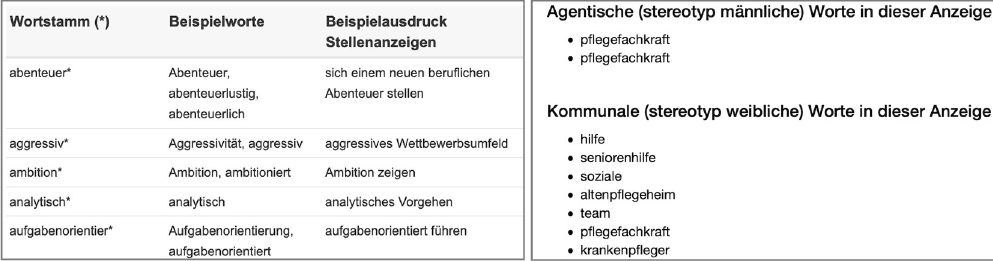
Fig 2. Word stems and examples of matching words in Fu¨hrMINT. Left: Sample of agentic word stems with word and context examples in job ad texts. Right: Example of extracted agentic and communal words. The word ‘pflegefachkraft’ (‘nursing professional’) matches the agentic stem ‘kraft’ and the communal stem ‘pflege’, and is displayed and counted w.r.t. to its occurrence in the